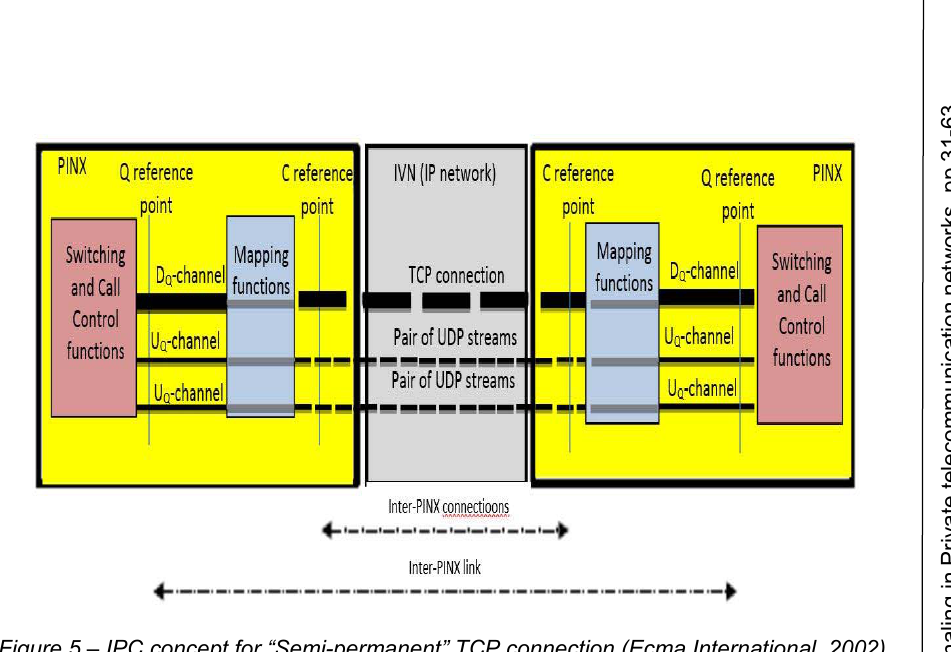
Figure 5 – IPC concept for “Semi-permanent” TCP connection (Ecma International, 2002) Рис . 5 – Концепция IPC для « полупостоянного » TCP- соединения (Ecma International,